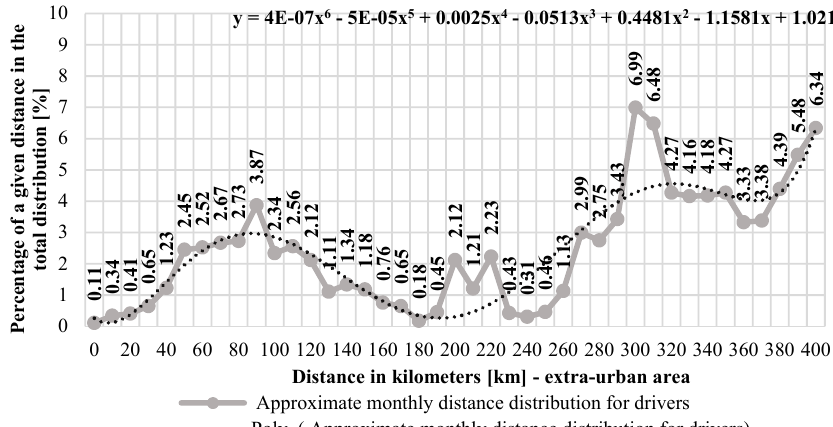
Figure 3. Daily distance distribution for ICEVs, PHEVs, and BEVs operated in extraurban mode— approximate value based on experimental tests.